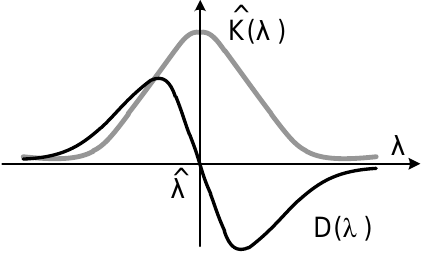
Fig. 2. Determination of the delay and initial phase of the received impulse based on the discriminatory